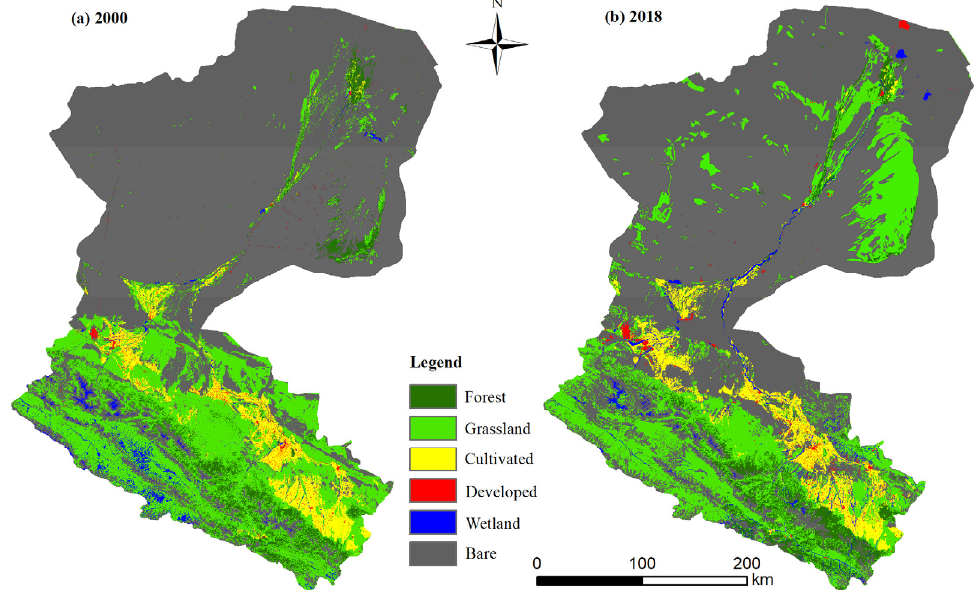
Figure 3. Land use/land cover in the Heihe River Basin in ( a ) 2000 and ( b ) 2018. In 2000, the area of grassland and bare land was 28,624.09 km 2 and 84,999.69 km 2 , respectively, accounting for 22.31% and 66.25% of the total area. In 2018, the area of grassland and bare land was 29,756.71 km 2 and 84,805.99 km 2 , respectively, accounting for 23.19% and 66.10% of the total drainage area (Table 1). From 2000 to 2018, the increase of grassland was mainly due to the transformation of bare land, reaching 10,858.44 km 2 . At the same time, 10,685.39 km 2 of grassland have been converted to bare land. That is: bare land and grassland are frequently changing into one another. In 2018, the area of forest was 5330.03 km 2 , which was mainly transformed from grassland and bare land, reaching 1791.01 km 2 and 639.66 km 2 , respectively. Meanwhile, in 2000, the area of forest land was 5857.63 km 2 , which was mainly transformed into grassland and bare land, reaching 2435.86 km 2 and 505.47 km 2 , respectively. In other words, forests, grassland, and bare land are also changing frequently. In 2000 and 2018, the cultivated land area was 6358.48 km (cid:2870) and 6066.47 km (cid:2870) , respectively, and the transfer area with other land types was small, less than 7%, although the scope of transfer is very large. In 2018, the developed land area was 756.67 km (cid:2870) , which was mainly converted from cultivated land and bare land, amounting to 305.4 km (cid:2870) and 131.98 km (cid:2870) , respectively. In 2000, the developed land area was 867.33 km (cid:2870) , mainly converted into grassland and cultivated land, followed by bare land. Finally, the developed land became more spatially dispersed. In 2000 and 2018, the wetland areas were 1588.86 km (cid:2870) and 1580.21 km (cid:2870) , respectively. Although the total amount was basically unchanged, the conversion range was also large. In 2018, wetlands were mainly converted from grassland and bare land, which amounted to 647.49 km (cid:2870) and 532.32 km (cid:2870) , respectively. From 2000 to 2018, wetlands were mainly turned into grassland and bare land. It can be observed that the types of land use in the HRB have changed frequently in the past 18 years.